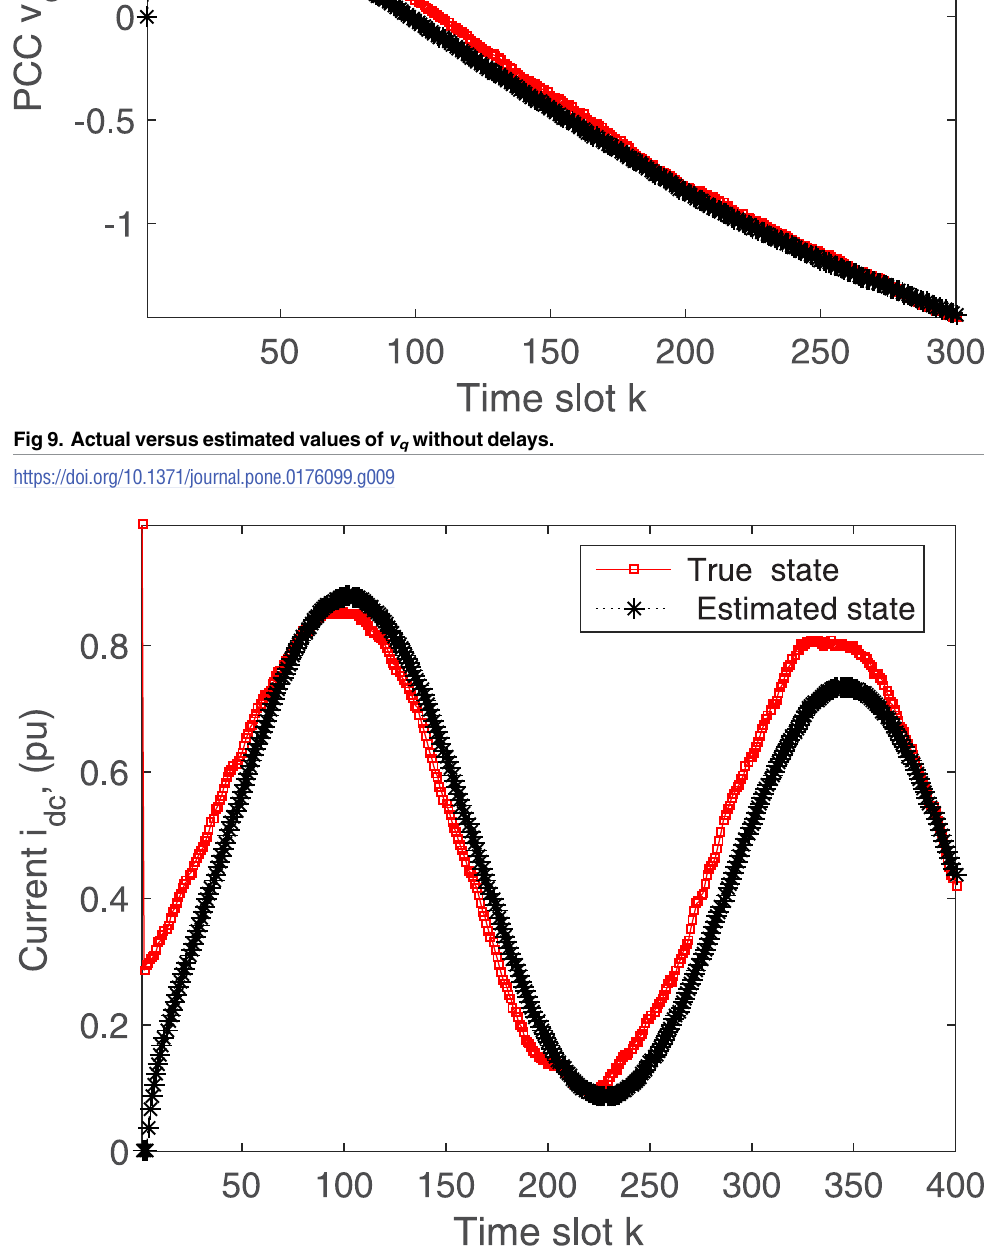
Fig 10. Actual versus estimated values of i dc with